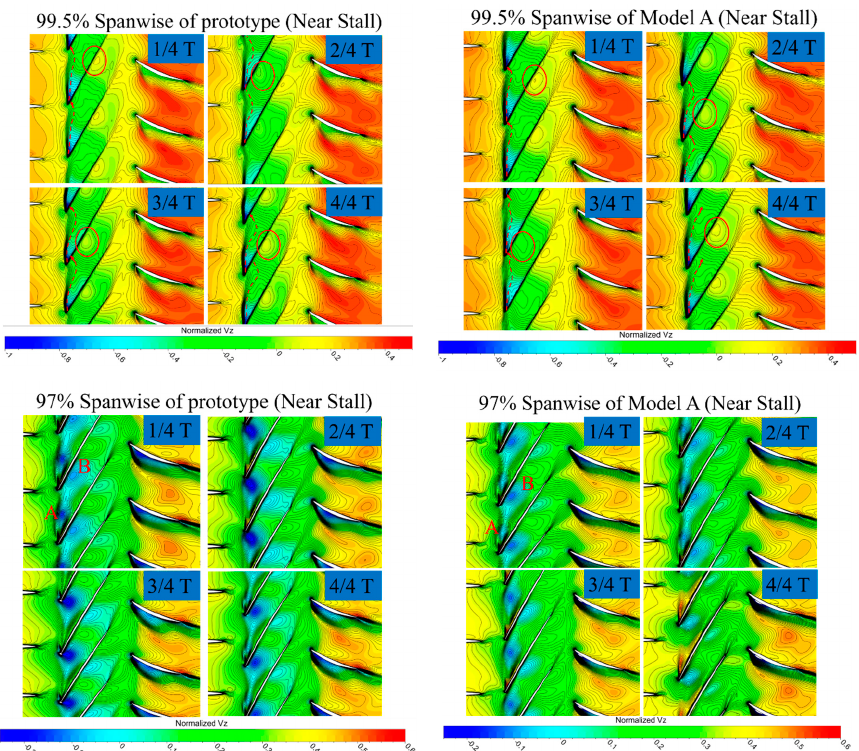
Figure 14. Transient axial relative velocity of the prototype and model A at 99.5% and 97% spanwise near the stall.